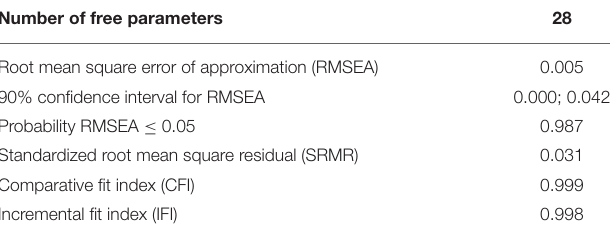
TABLE 2 | Goodness-of-fit of the